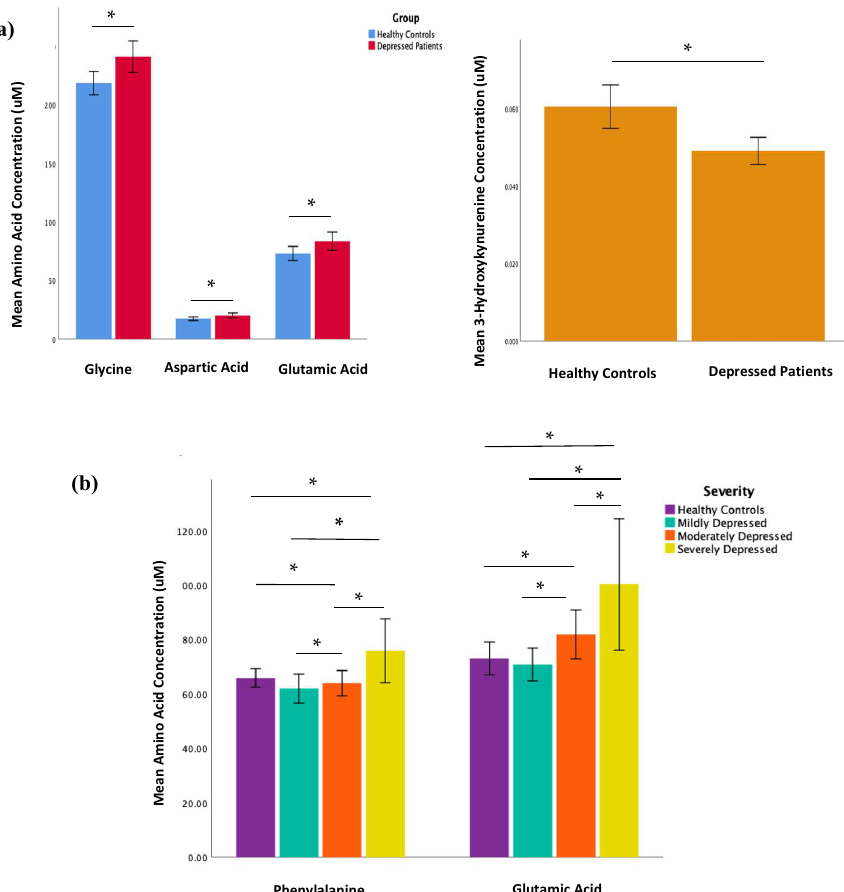
Figure 1. Comparison of mean metabolite concentrations in blood serum of ( a ) HCs (n = 70) and MDD patients (n = 70) and ( b ) HCs (n = 70) alongside MDD patients with differing disease severity (n = 21 mild MDD; n = 30 moderate MDD; n = 19 severe MDD) * p value ≤